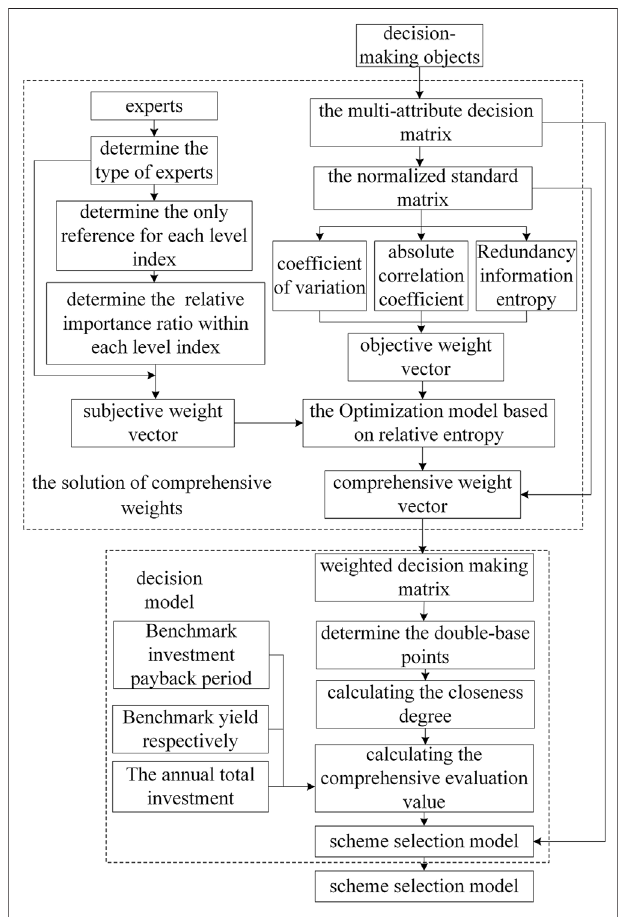
FIGURE 2 | Comprehensive decision